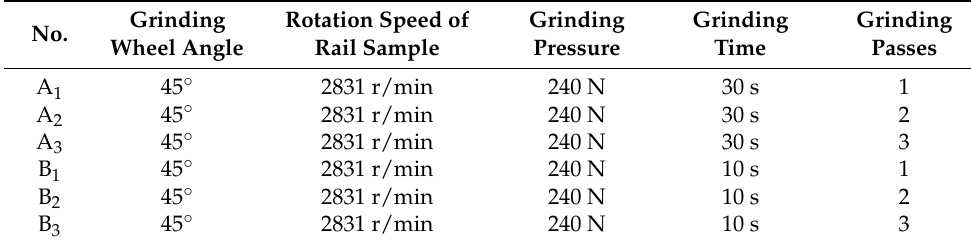
Table 4. Grinding parameters of grinding time on grinding